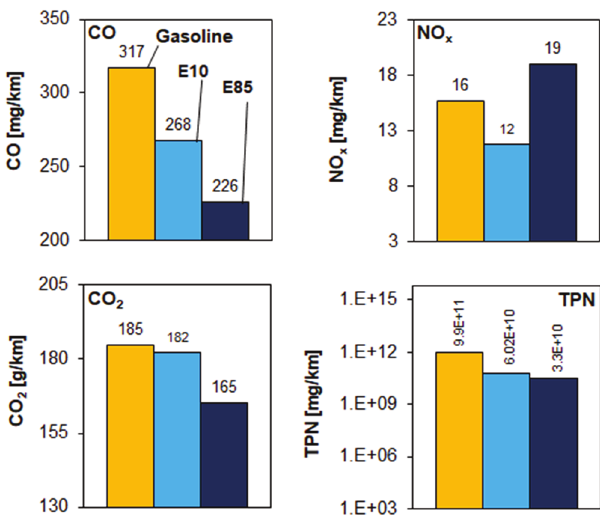
Fig. 4. Average emissions in WLTC warm, with gasoline E10 & E85 V1: Volvo V60 T4F,